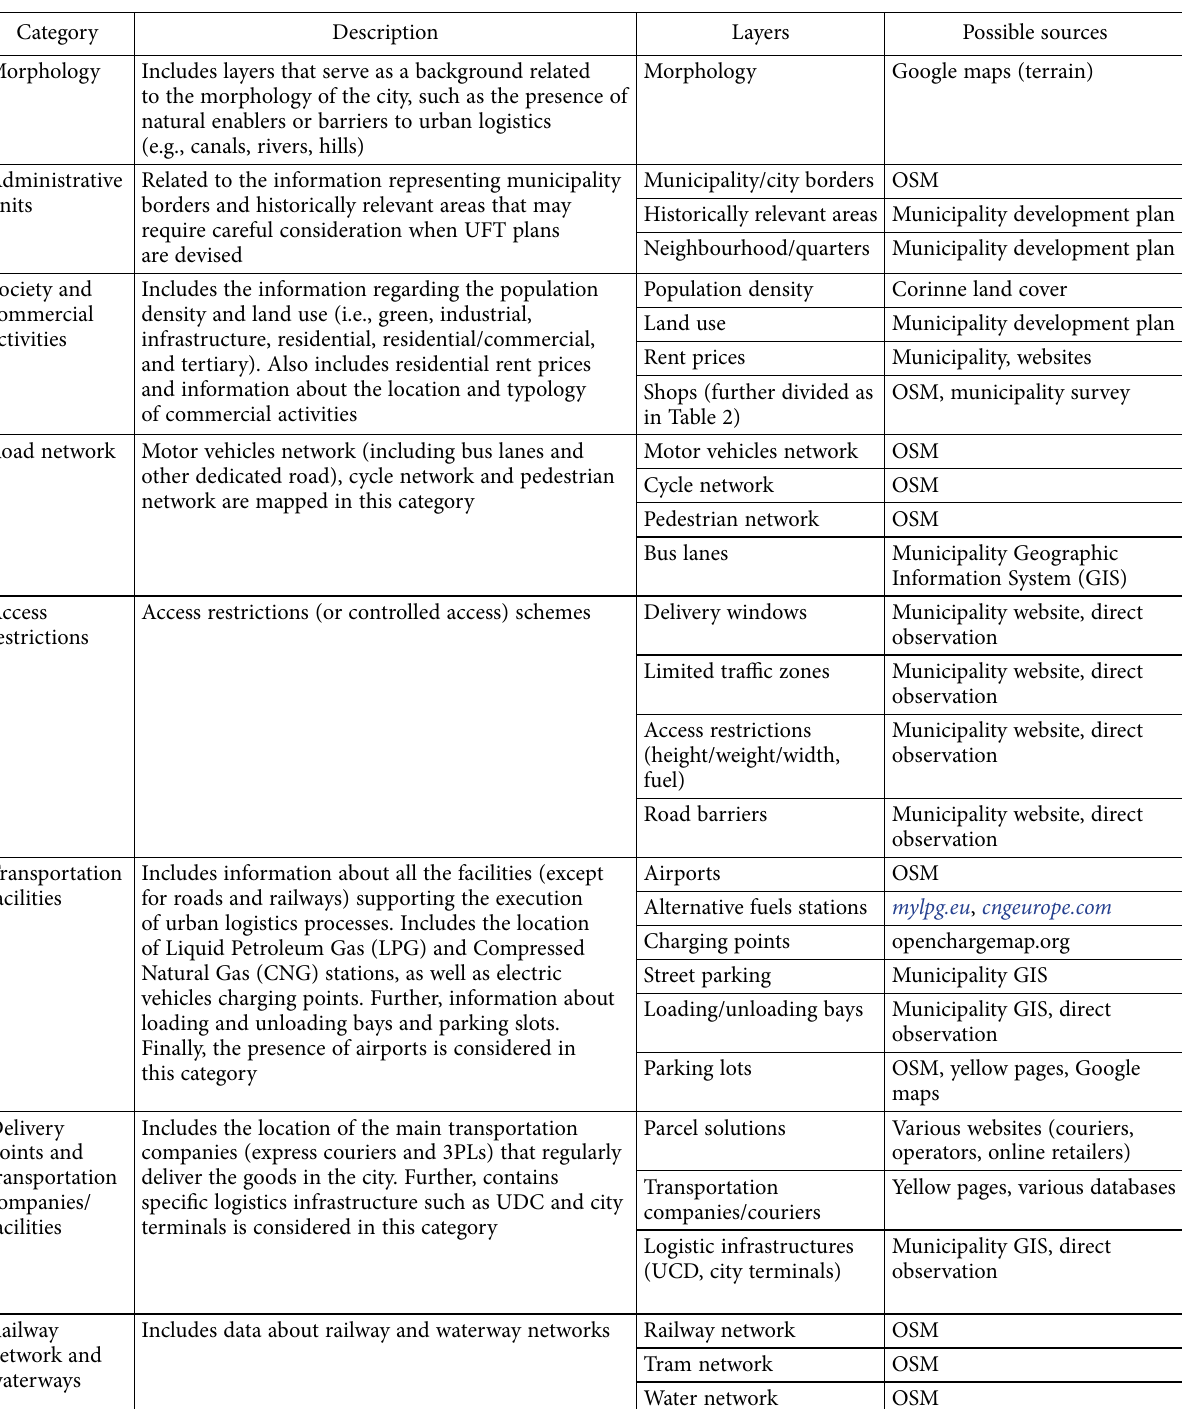
Table 3. Information used in the framework and